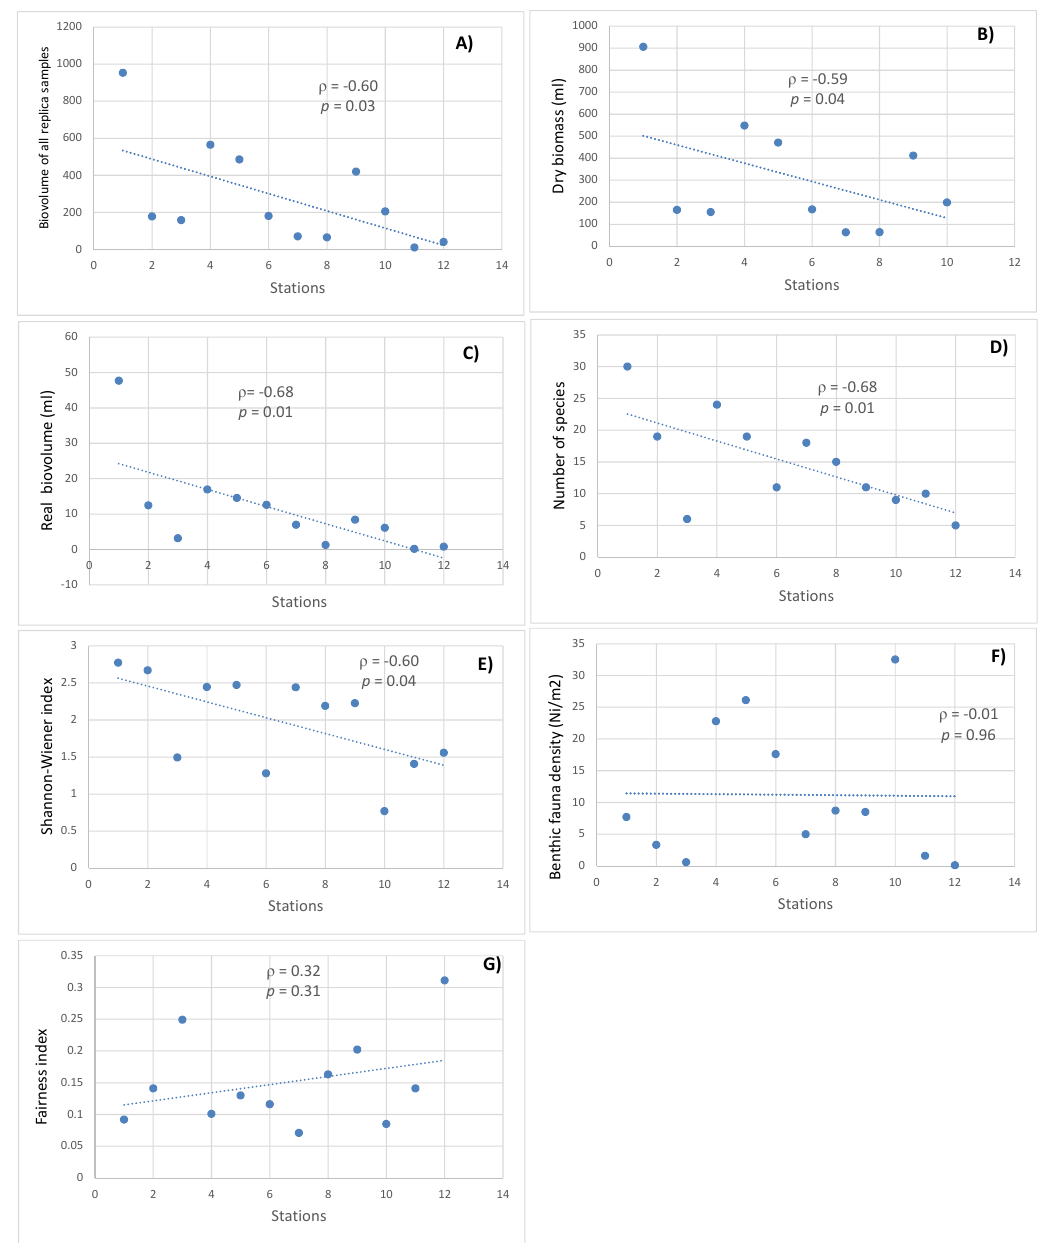
Figure 9. Relationships between ( A ) the total biovolume of all replicate samples, ( B ) dry biomass, ( C ) real biomass, ( D ) total number of species per station, ( E ) Shannon ‐ Wiener index, ( F ) density, and ( G ) fairness index and the distance of sampling stations.